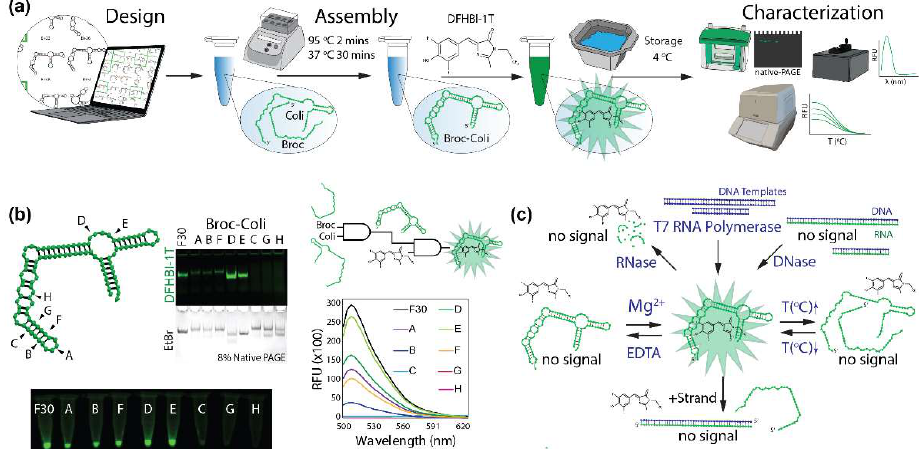
Figure 1. Computer-aided design, assembly, and characterization of fluorets. ( a ) Schematic representation of experimental pipeline with used experimental techniques indicated. ( b ) Positions of cuts (denoted A–H) chosen to be tested in this work and assessment of functionalities with native-PAGE and fluorimetry. Conditional activation of fluorescence is schematically demonstrated by AND gates. ( c ) Schematic representation of conditional activation and deactivation of fluorets tested in this work.